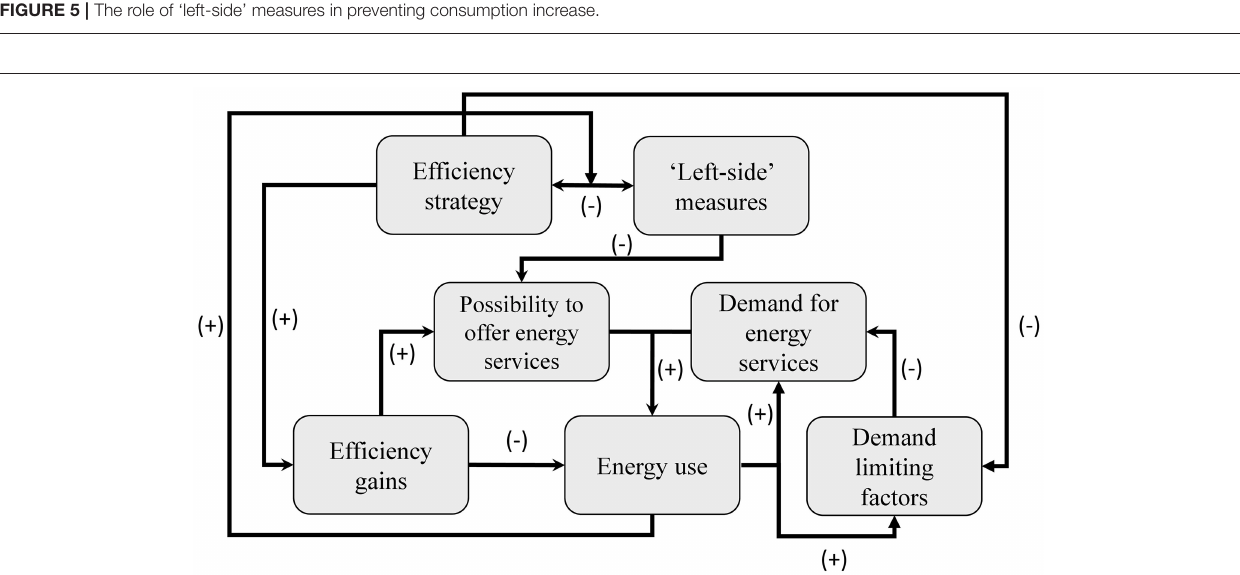
FIGURE 6 | Comprehensive view of the model: interrelations of beneficial and adverse effects of different strategies to reduce energy consumption.